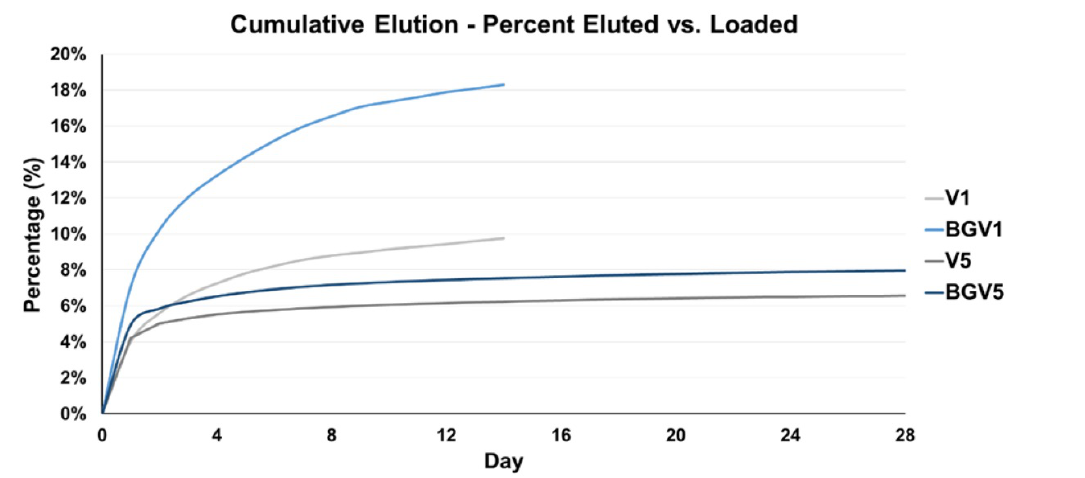
Figure 4. Cumulative average of vancomycin eluted from each group (n=10) as a percentage of vancomycin contained within each group over the treatment